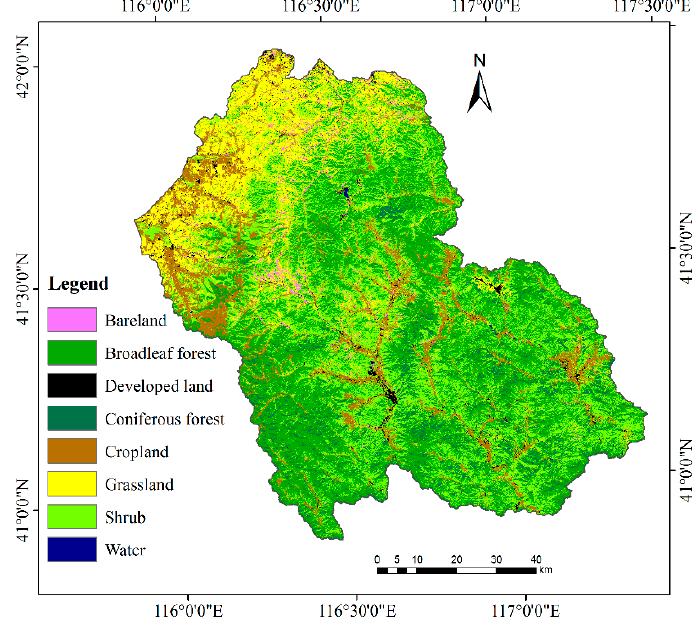
Figure 7. Distribution of the land cover types based on the SVM land cover classification for Scenario 4 (combination of the composited GF-1 multi-spectral bands and the phenological parameters).